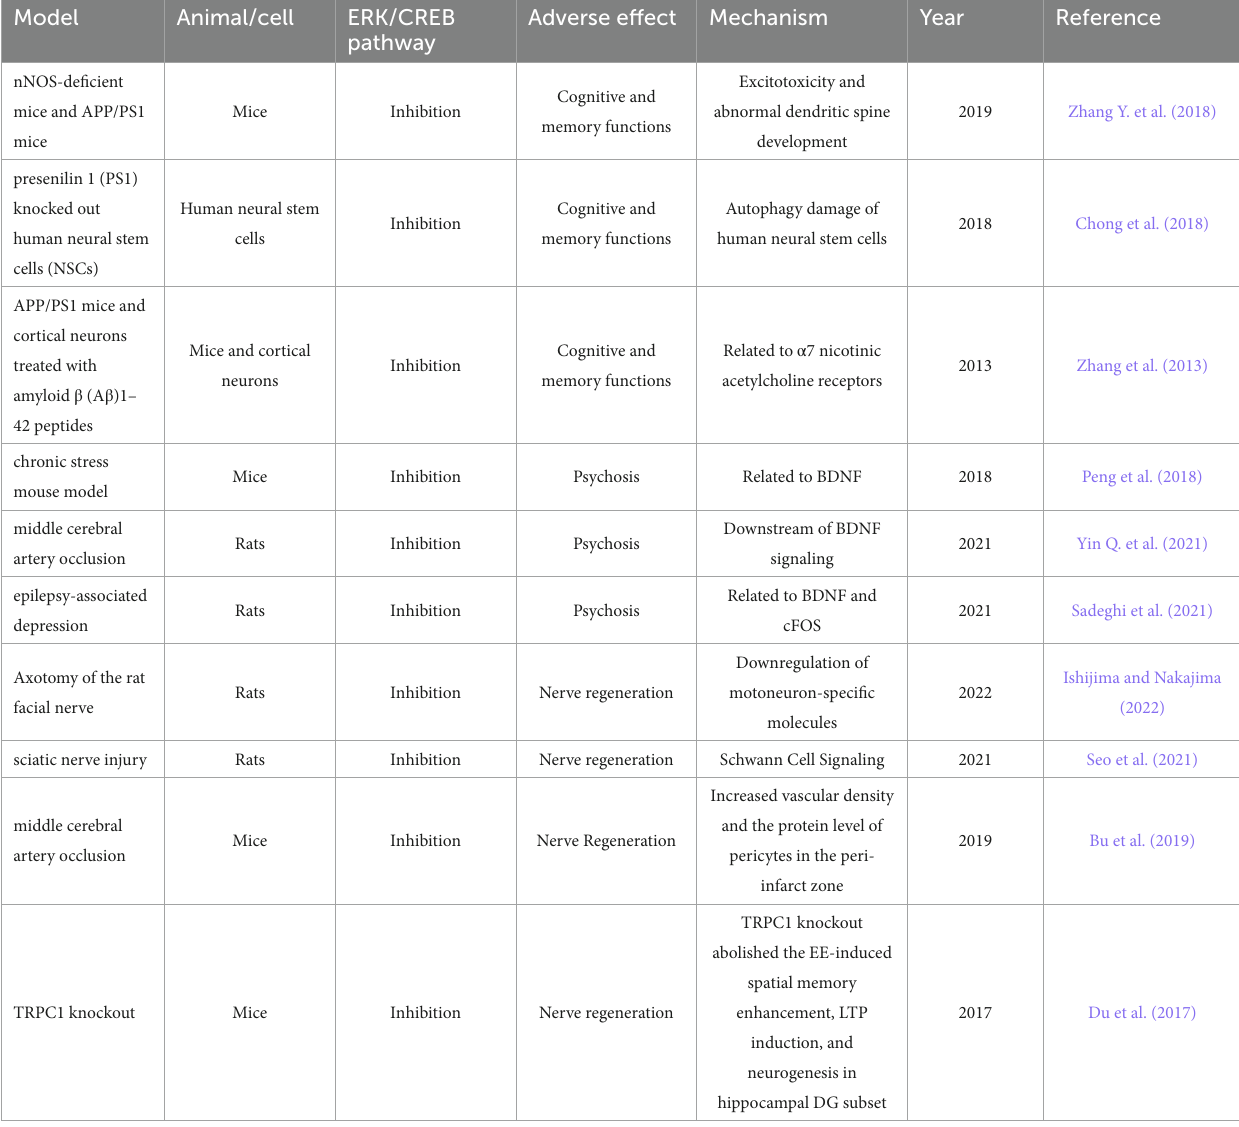
TABLE 2 The mechanism of adverse effects of the nervous system related to ERK/CREB pathway